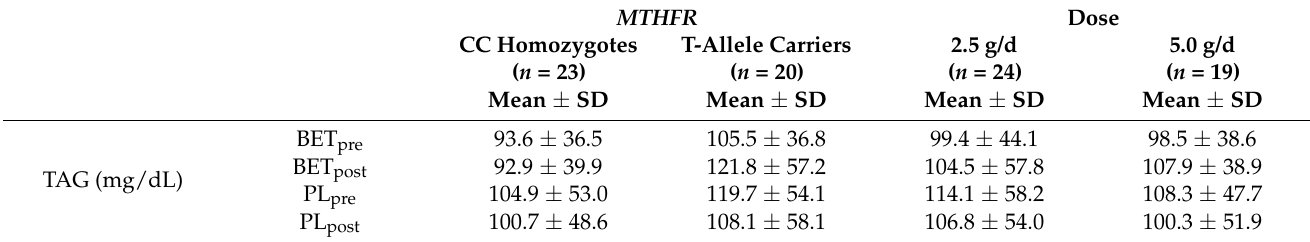
Table 4. The effect of betaine supplementation on lipid profile, as well as homocysteine and glucose concentrations in regard to MTHFR genotype and dose of